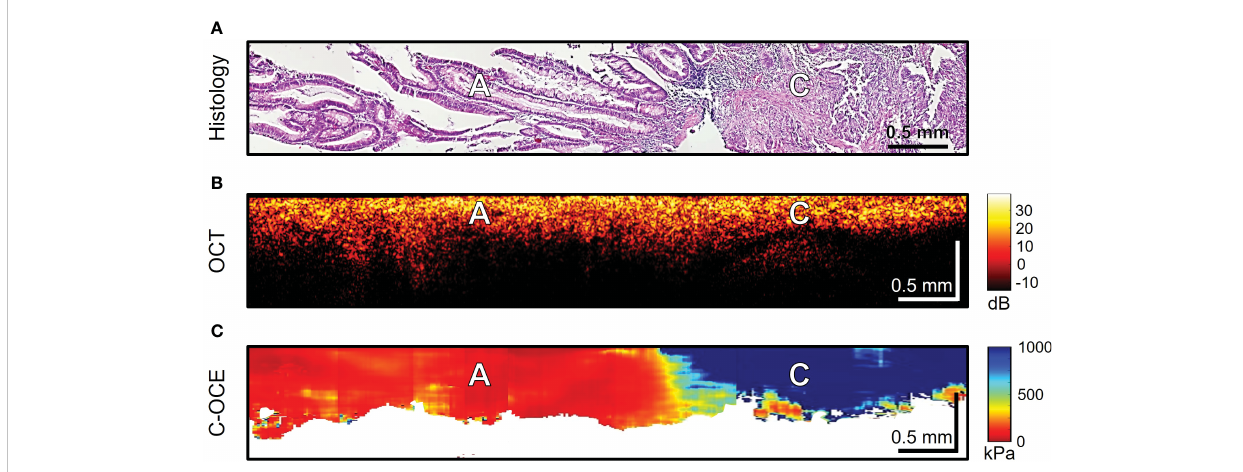
FIGURE 7 Example of morphological examination of high-grade colorectal adenocarcinoma (high-grade CRAC) tissues by C-OCE: non-glandular cancer tissue [C] has very high stiffness (954 ± 156 kPa) in comparison with adenoma [A] (46 ± 22 kPa). Corresponding tissue areas in histological (A) , OCT (B) and C-O С E (C) images. Bar size is shown in the